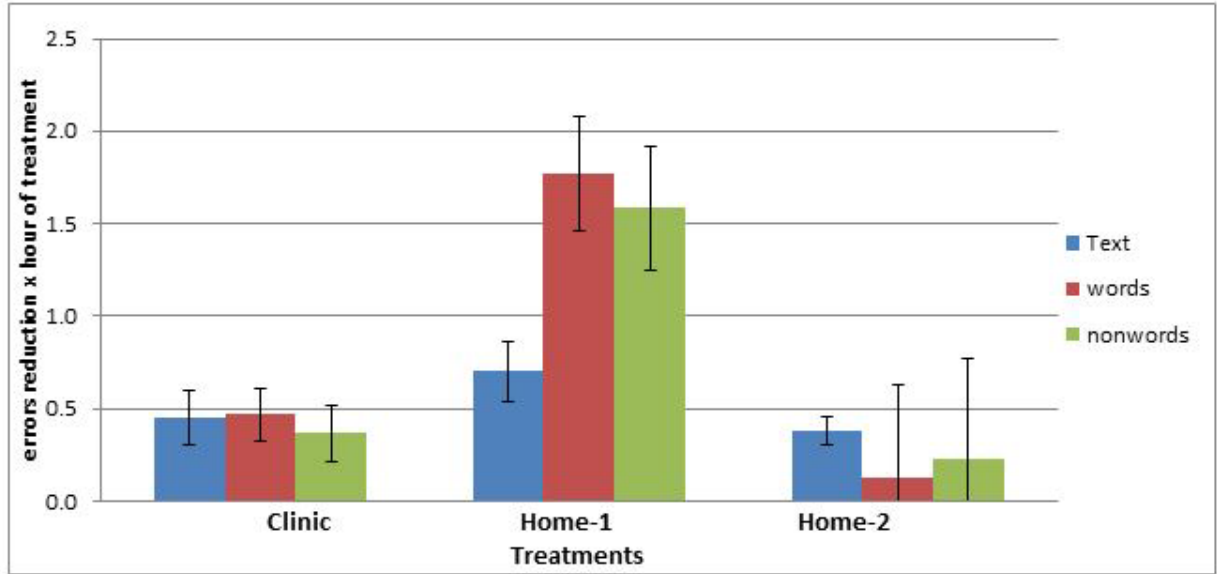
Figure 4. Means of errors reduction x hour of intervention, obtained by the three different treatments in reading text, words and nonwords.